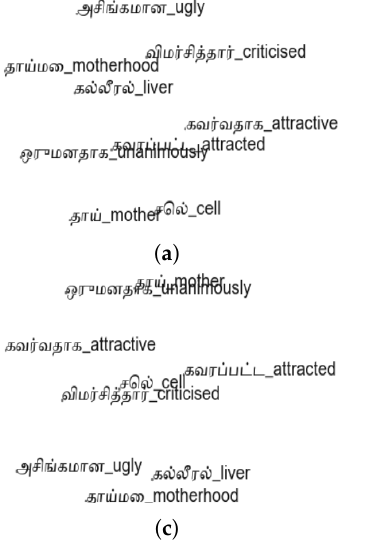
Figure 12. t-SNE visualization of transfer learned Tamil vectors (MLP and CNN) and original vectors generated by FastText. ( a ) Original Embeddings; ( b ) Embeddings generated by MLP; ( c ) Embeddings generated by CNN.